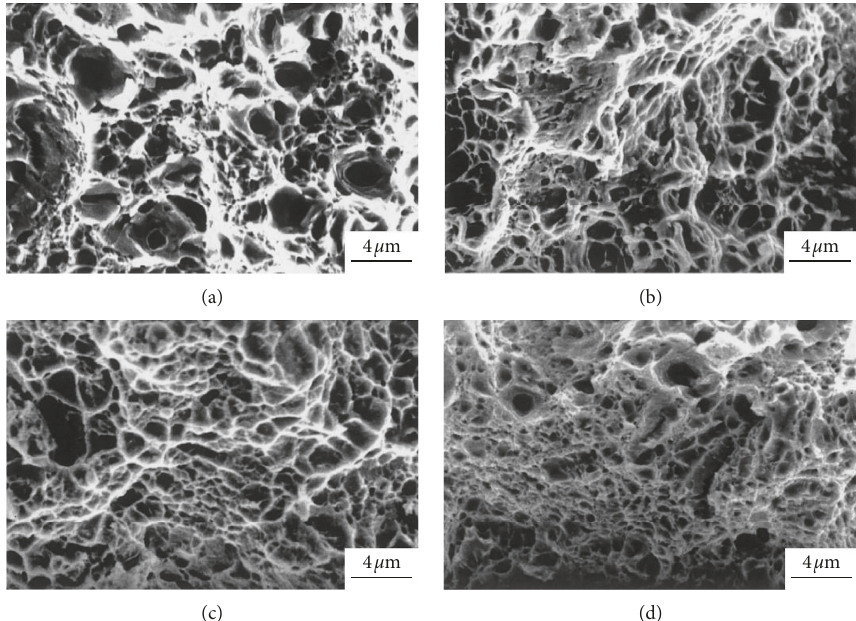
Figure 12: Fracture morphologies of 34CrNiMo6-xCe specimens quenched in oil (870 ° C/30min) and tempered at 650 ° C: (a) x quenched in oil (870 ° C/30 min), (b) x